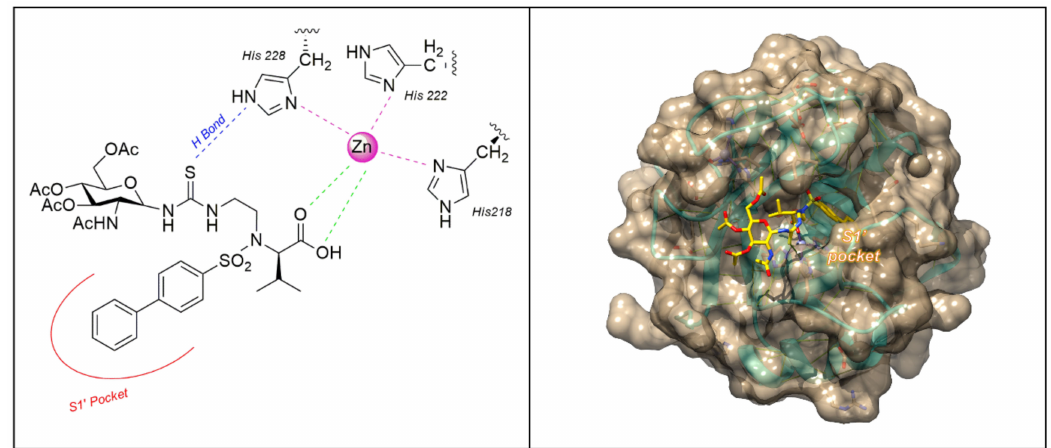
Figure 8. The binding mode of 14 [76] in MMP-12 catalytic domain (PDB: 5I0L). Image generated with Chimera, version